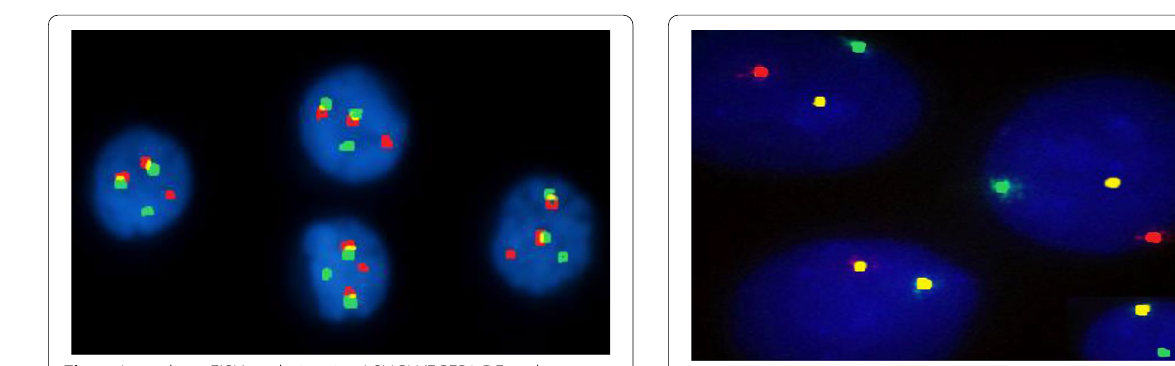
Fig. 4 Interphase FISH analysis using Vysis LSI IGH dual color break apart rearrangement probe showing positive result for IGH rearrangements